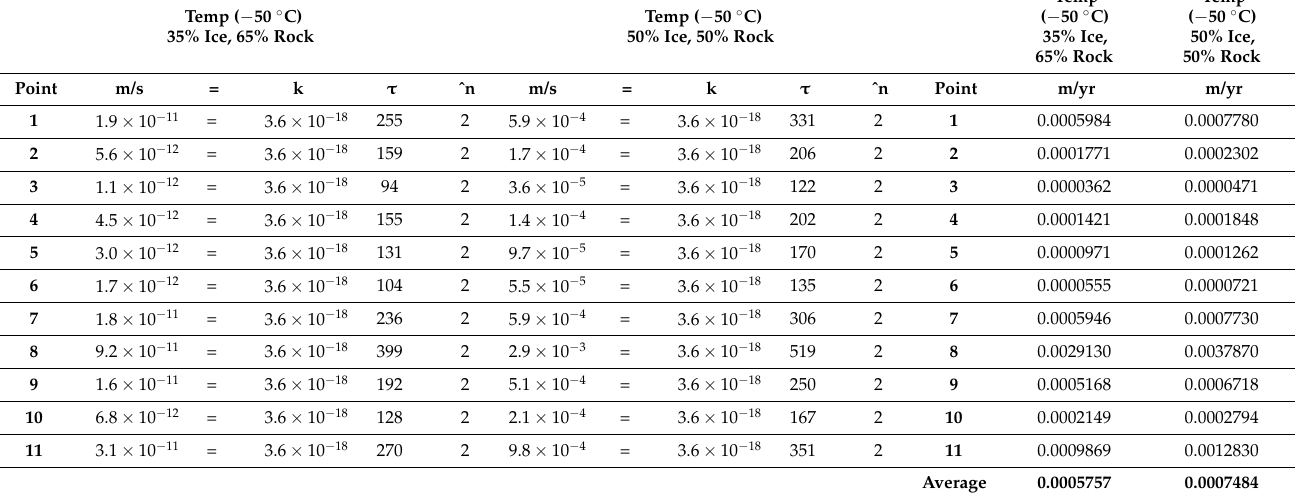
Table 2. Surface Flow Calculations for the Red (1) lobate feature located on the north slope of Mount Sharp. Upper table for temperature of − 50 ◦ C. Lower table for temperature of 0 ◦ C. Points 1–11 correspond to the data sites located on the Red (1) lobate feature (see Figure 6 for locations). Surface Flow Rate (m/yr) from (Formula (4)). Values of the flow parameter k for shear stress n = 2,